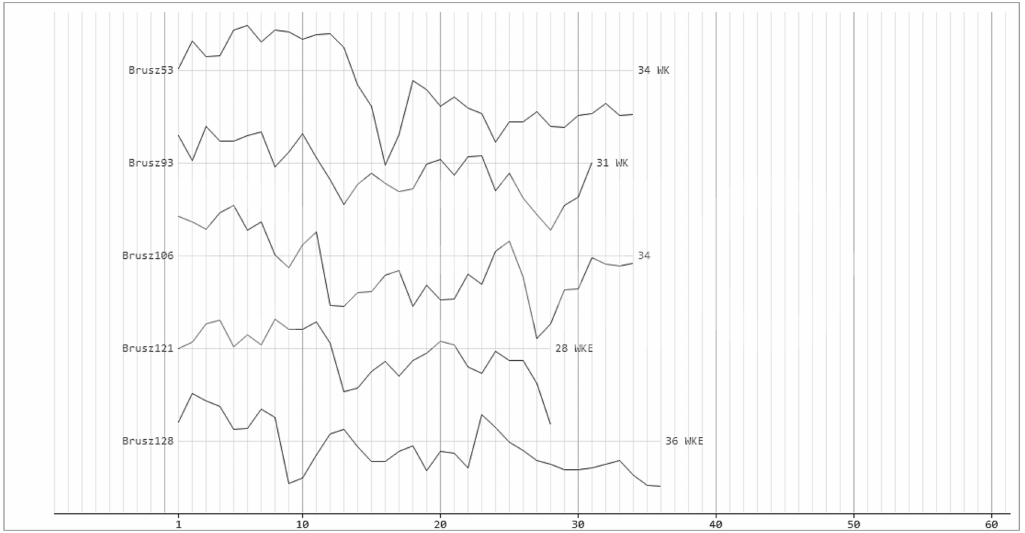
Figure 6. Examples of growth-ring sequences from coppiced